Question: State the chart type depicted above.
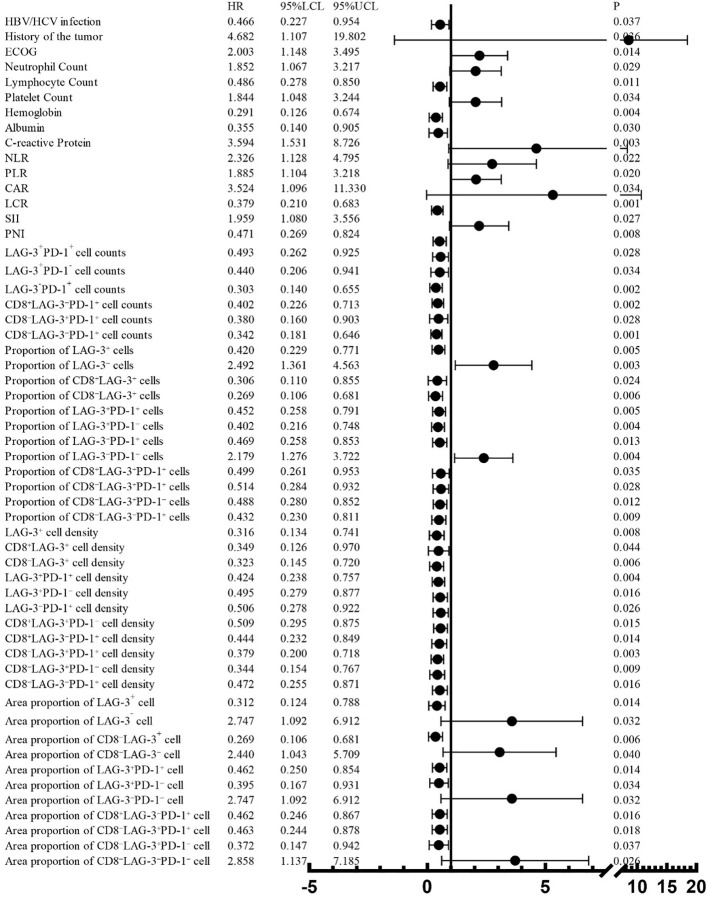
Answer: forest